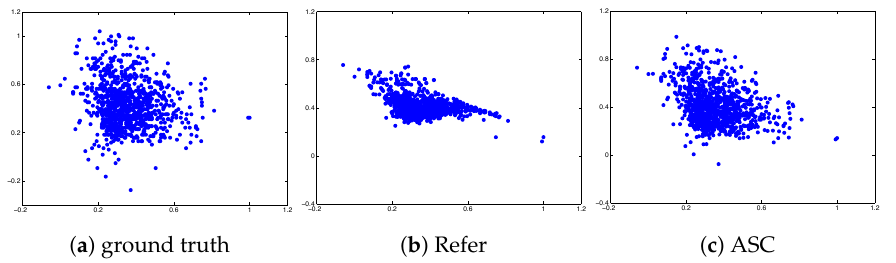
Figure 5. Visualization of wind speed and reconstructed pressure on a weather station in San Francisco (x-axis: wind speed, y-axis: reconstructed pressure produced by different approaches). Ground truth corresponds to the true pressure values. Values are in normalized